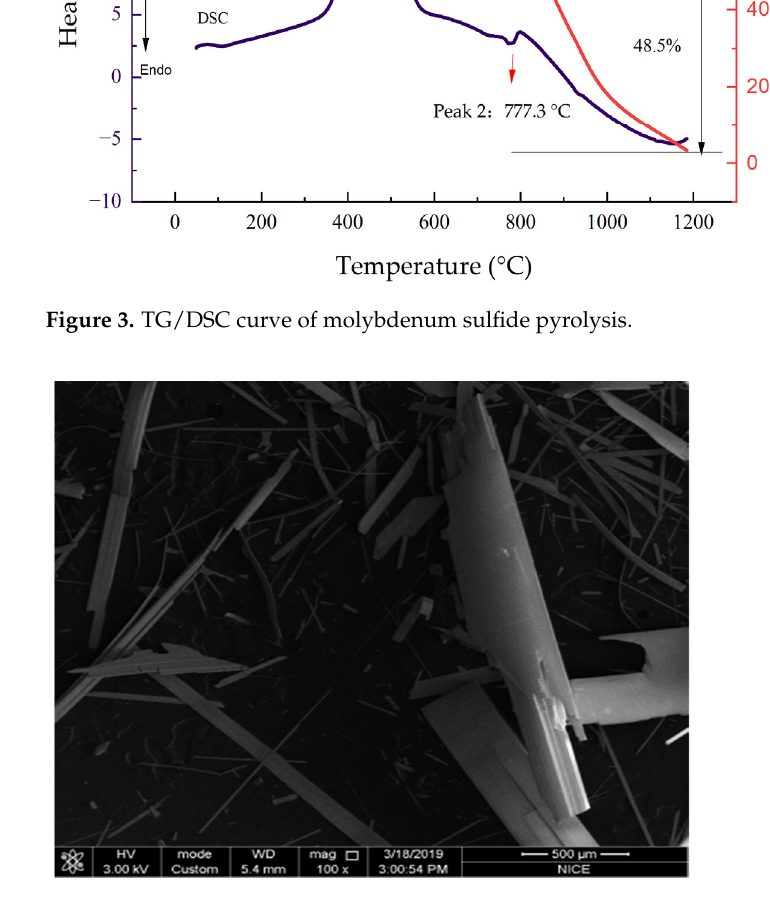
Figure 5. TG curve of DCLR (ER) -MoO 3 Pyrolysis. As illustrated in Figure 5, samples with varying mass ratios exhibited similar ther- mogravimetric characteristics that can be roughly classified into three stages: the first stage (400~600) °C, the second stage (600~747) °C, and the third stage (747~1200) °C DCLR (ER) -MoO 3 -3 had the highest weight-loss rate in the first stage, at 63.1%. At the same stage, the weight-loss rates for DCLR (ER) -MoO 3 -2 and DCLR (ER) -MoO 3 -1 were 46.3% and 26.3%, respectively, corresponding to the characteristics of DCLR (ER) -MoO 3 -1 < DCLR (ER) - MoO 3 -2 < DCLR (ER) -MoO 3 -3. Based on the component content of the samples, it can be considered that the first stage is primarily the pyrolysis reaction process of organic com- ponents in DCLR, such as coal and asphalt. The third stage curve followed the opposite trend to the first stage. DCLR (ER) -MoO 3 -1, DCLR (ER) -MoO 3 -2, and DCLR (ER) -MoO 3 -3